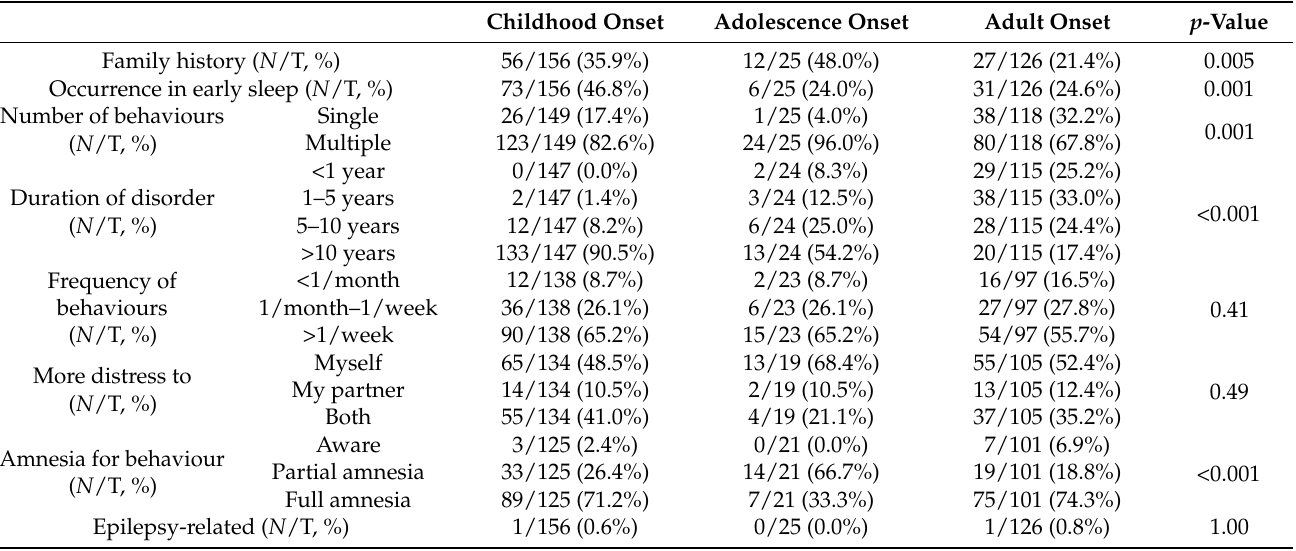
Table 2. Parasomnia related characteristics in patients with NREM parasomnias split by age of onset ( p at 0.05/3 = 0.017).